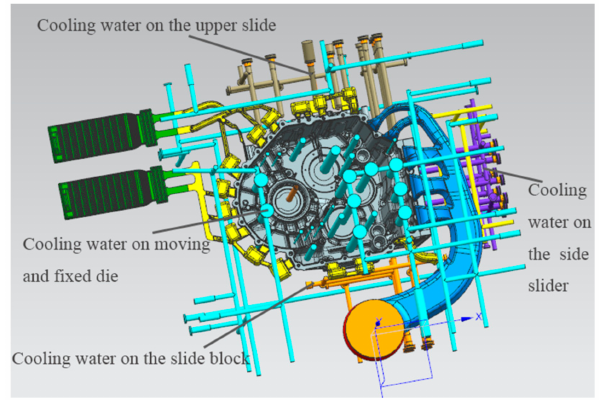
Figure 5. Diagram of product gating system with cooling system.